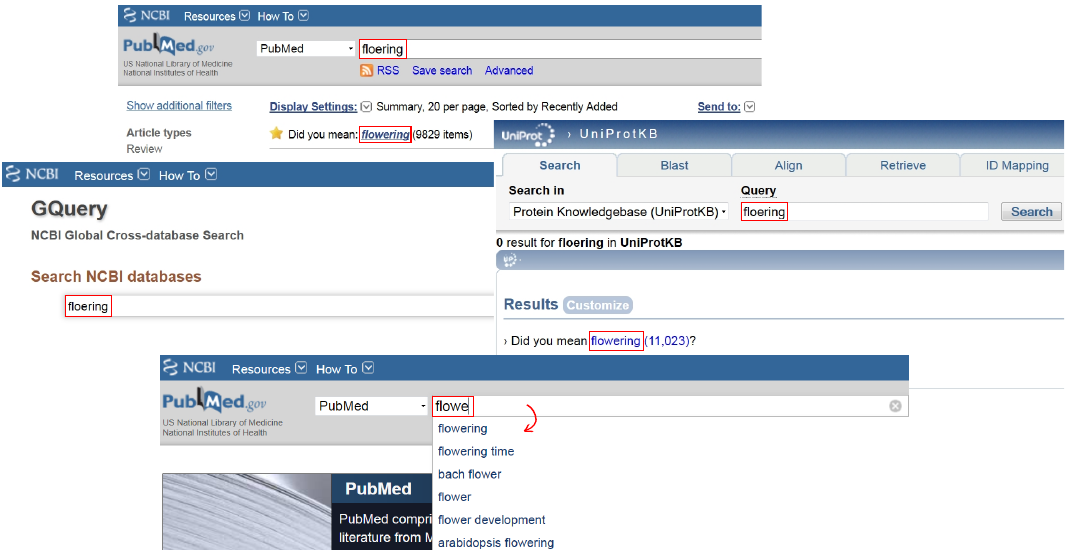
Figure 1: Screenshots from the 16 of January 2014 ,which show the “Did you mean” function of UniProt, PubMed and Entrez GQuery. The figure also shows the query expansion for